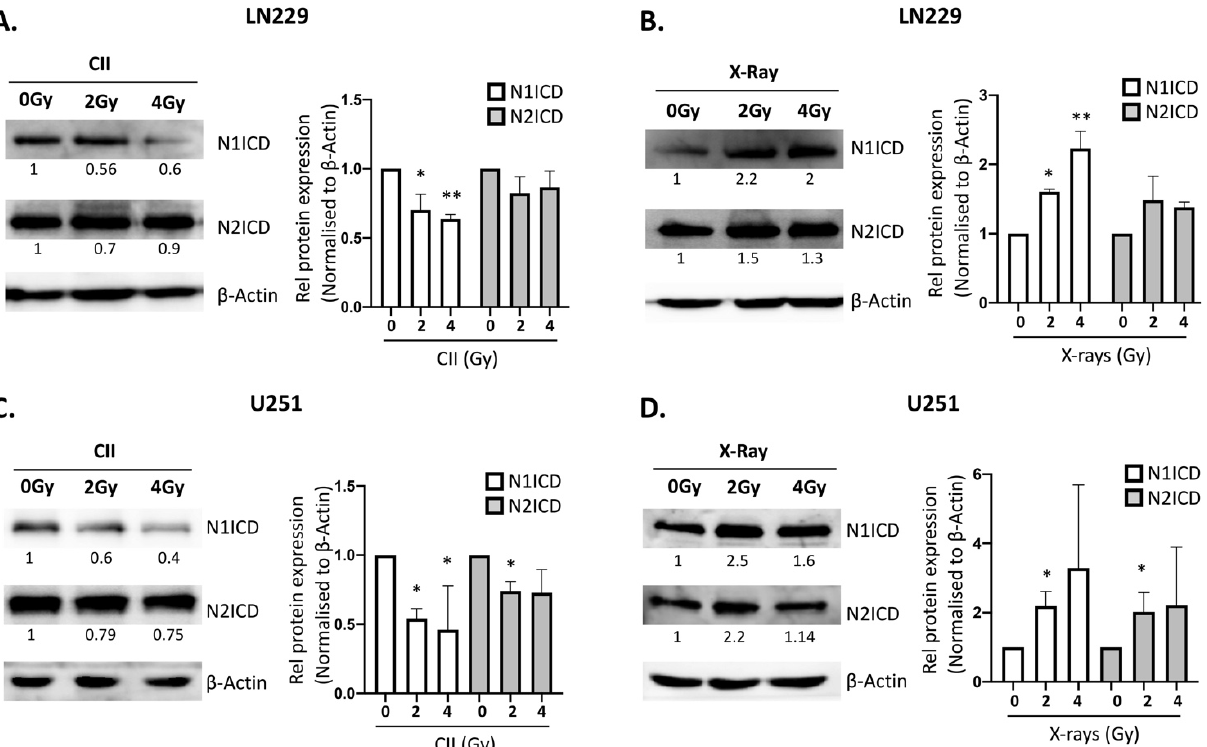
Figure 2. CII reduces while X-Ray enhances NOTCH1ICD and NOTCH2ICD protein levels: Western blot analysis of NOTCH1, NOTCH2, and β -ACTIN as a loading control in ( A ) LN229 irradiated with CII, (right) densitometry analysis of protein level in panel A; values are average of three independent experiments; ( B ) LN229 irradiated with X-Ray, (right) densitometry analysis of protein level in panel B, values are average of two or more independent experiments; ( C ) U251 irradiated with CII, (right) densitometry analysis of protein level in panel C, values are average of three independent experiments; ( D ) U251 irradiated with X-Ray, (right) densitometry analysis of protein level in panel D, values are average of two or more independent experiments. Data are presented as mean ± SD. Statistical analysis was performed by ANOVA with Bonferroni post-hoc test. p -value (* p < 0.05, ** p < 0.01).